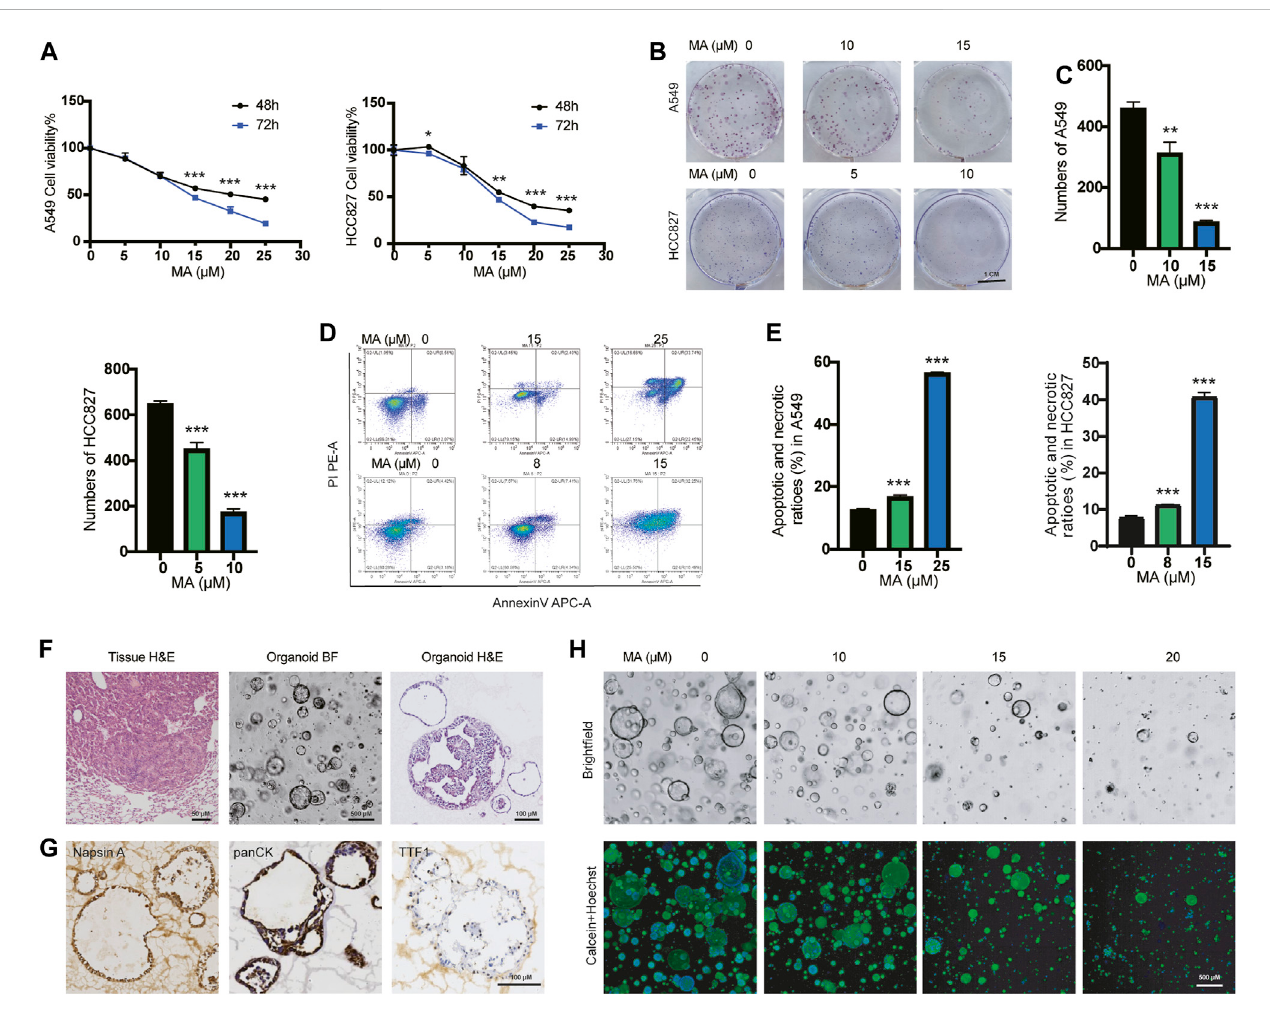
FIGURE 1 MAinhibitstheproliferation oflungcancercellsandorganoids. (A) TheviabilityofA549 andHCC827cellswereexaminedbyCCK8assayafter treatment with different concentrations of MA for 48 and 72 h. (B) Representative results of crystal violet staining for colony formation. (C) Quantitative analysis of the colonynumberofA549andHCC827cells. (D) RepresentativeresultsofannexinV/PIstaining. (E) QuantitativeanalysisofapoptosisinA549andHCC827cells. (F) H&E staining of tumor tissue from the KRAS G12D mouse model, as well as representative bright fi eld (BF) microscopy images and H&E staining of organoids. (G) Immunohistochemistry analysisoflung adenocarcinoma markers TTF1, Napsin A,and theepithelialmarkerpanCK inorganoids. (H) Bright fi eld and Calcein staining of organoids after treatment with different concentrations of MA. * p < .05, ** p < .01, *** p <